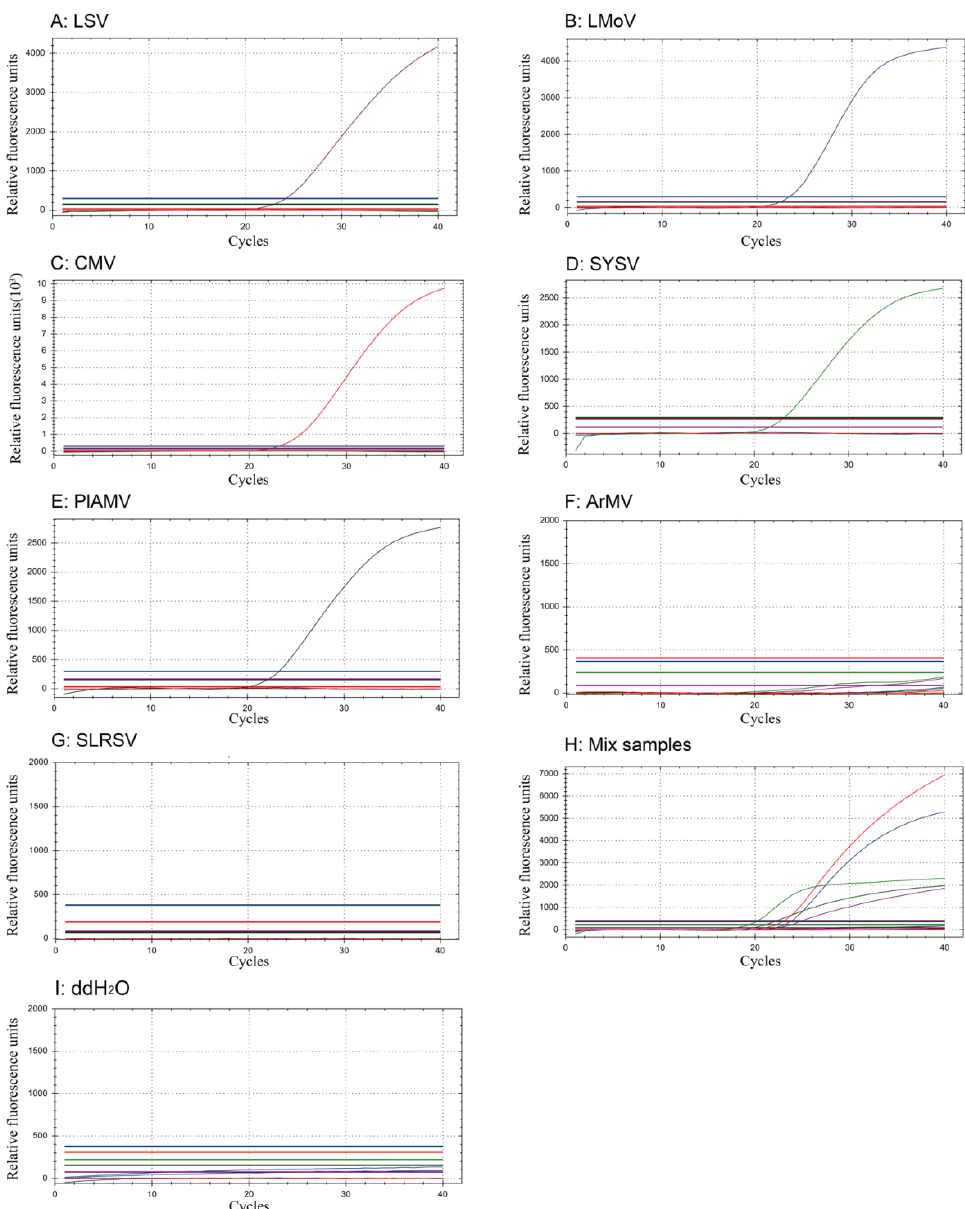
Figure 5. Specificity of multiplex TaqMan real-time PCR. The specific fluorescent signals were detected in the positive samples of LSV ( A ), LMoV ( B ), CMV ( C ), SYSV ( D ), and PlAMV ( E ) and mixed samples ( H ). No cross-reactions were detected from ArMV ( F ) and SLRSV ( G ) and ddH 2 0 ( I ).